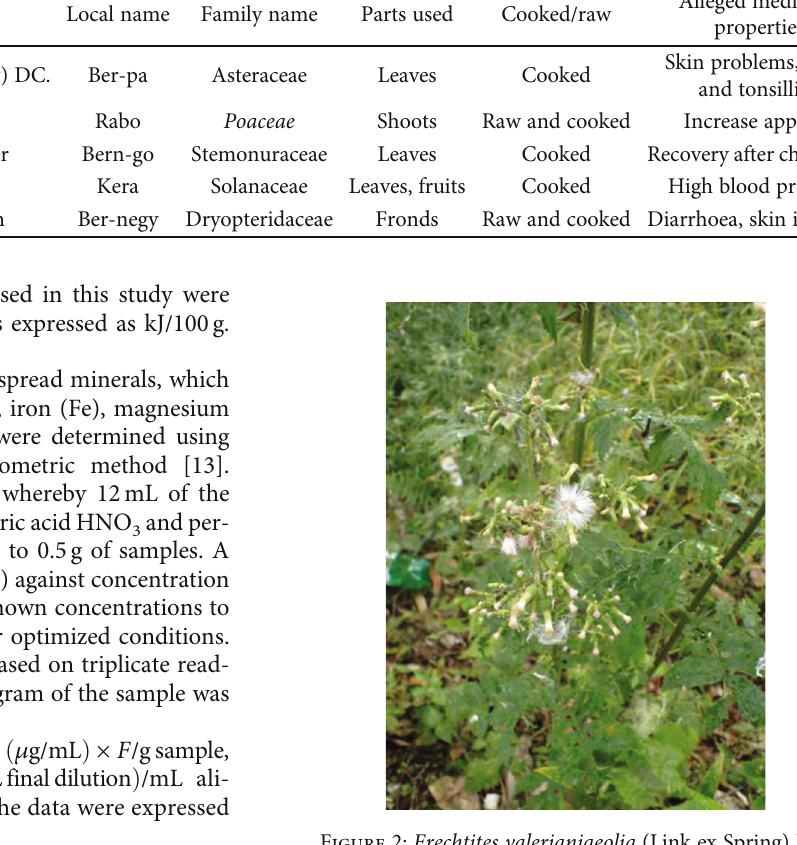
Figure 2: Erechtites valerianiaeolia (Link ex Spring)